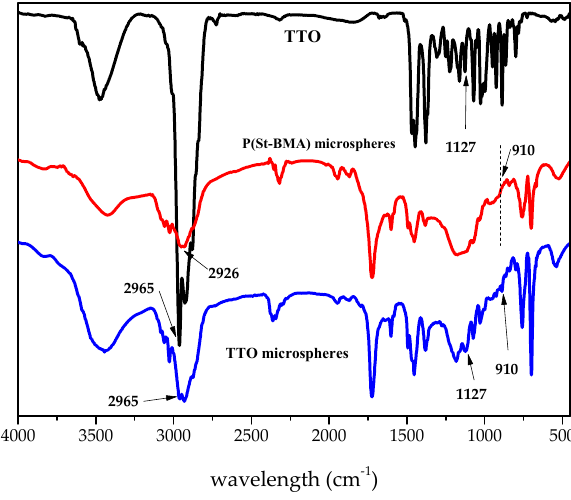
Figure 1. FTIR spectra of TTO, P(St-BMA) microspheres, and TTO microspheres.